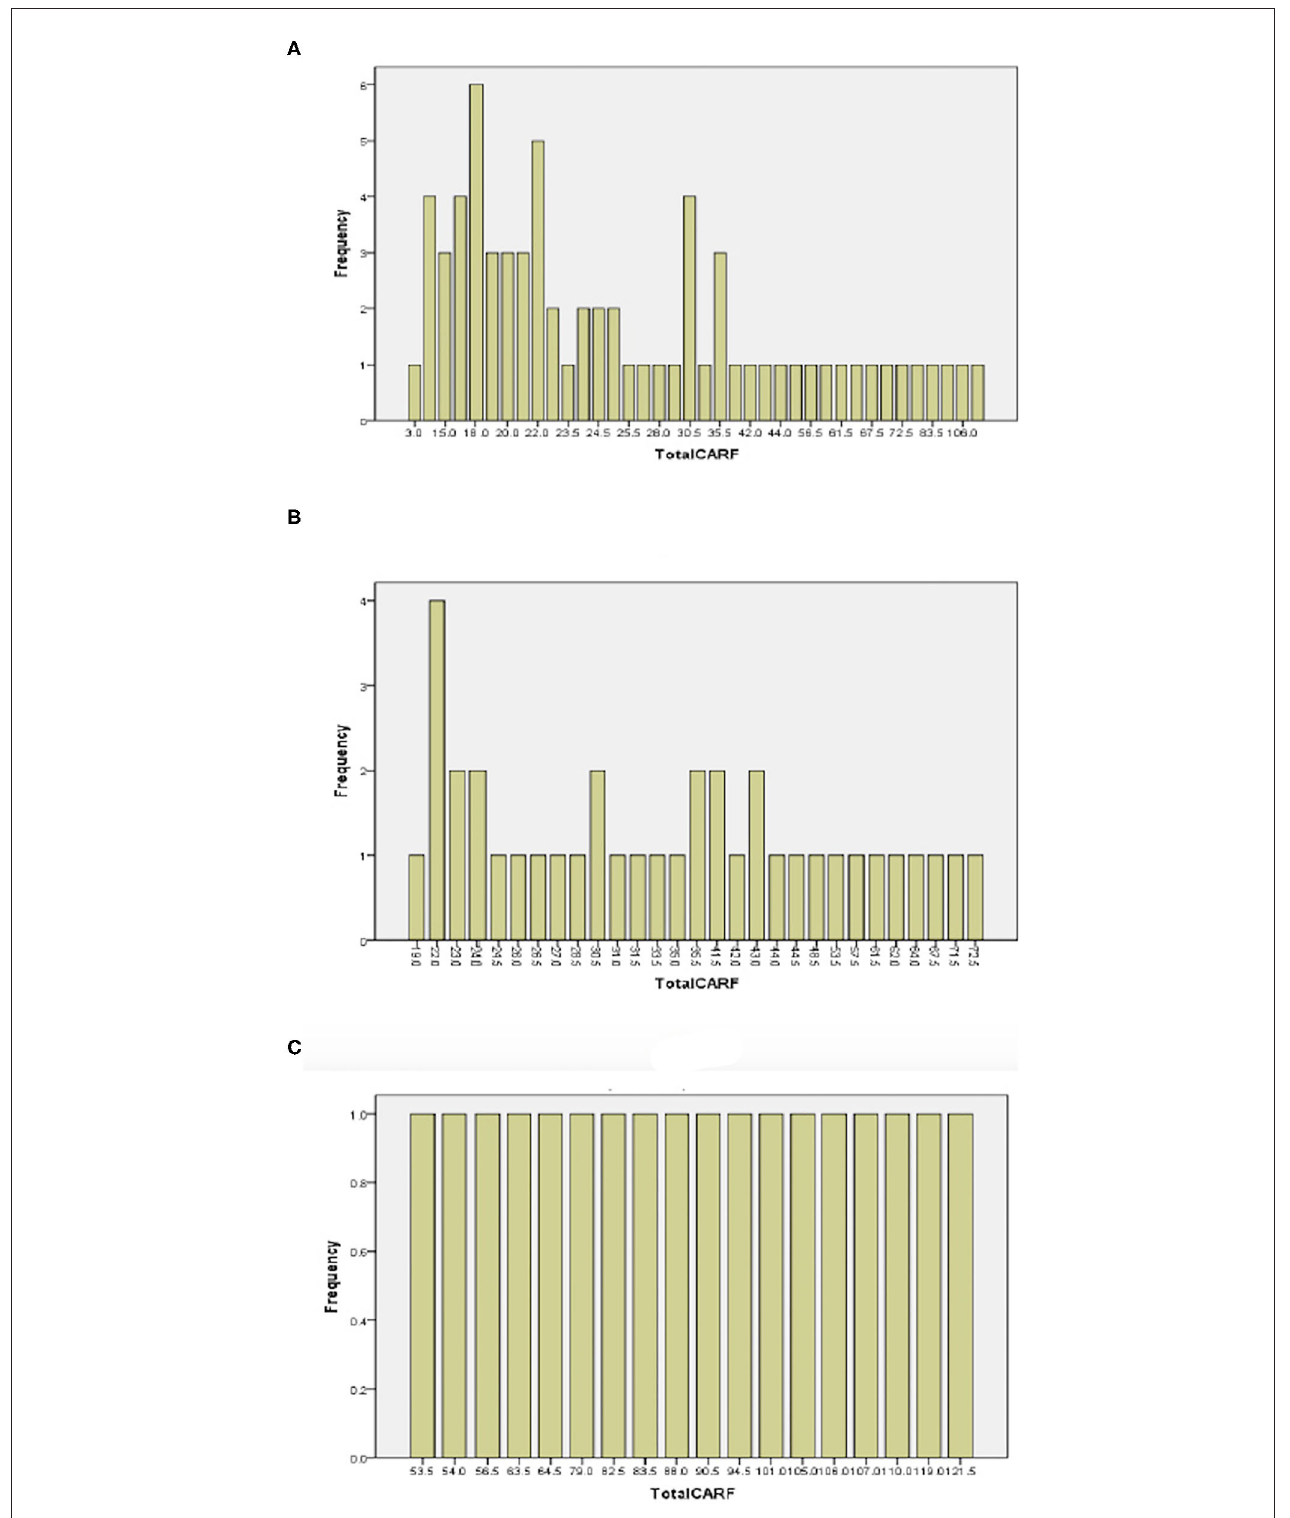
FIGURE 2 | Frequency plots of overall CARF score in older participants (A) , persons with stroke (B) , and persons with spinal cord injury (C) .